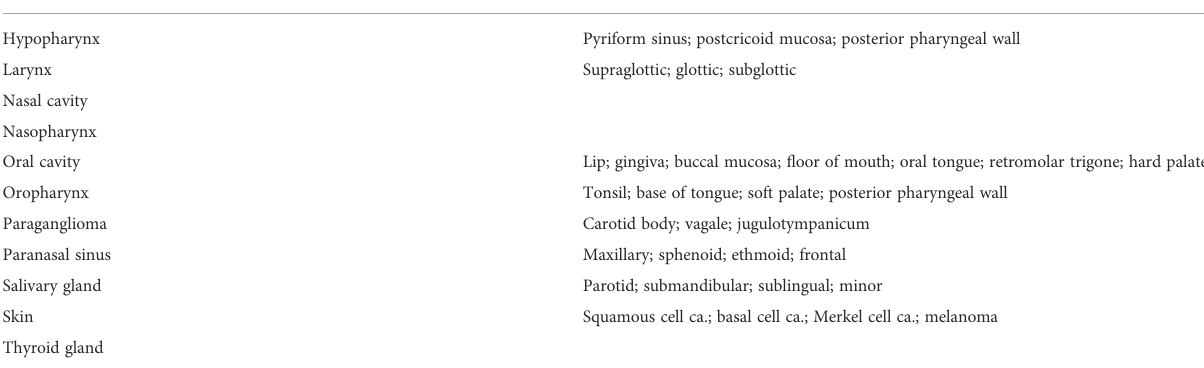
TABLE 2 H&N cancer sites or histologies for cases included in our curated dataset.